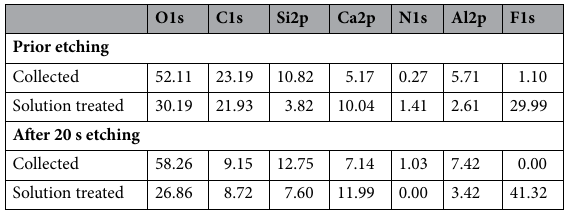
Table 2. XPS data for untreated and solution cured dusts.